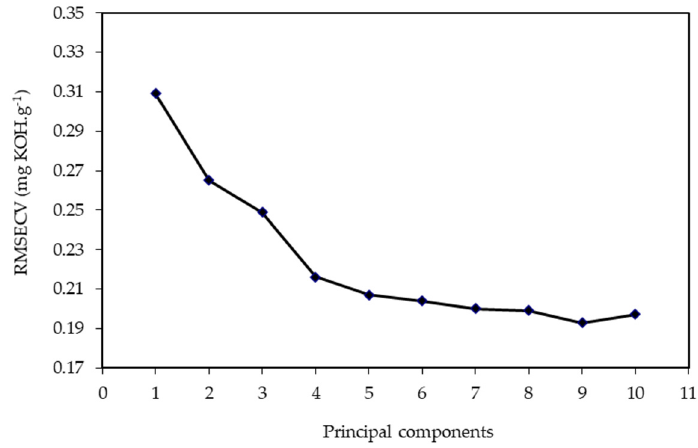
Figure 3. RMSECV depending on the number of principal components .